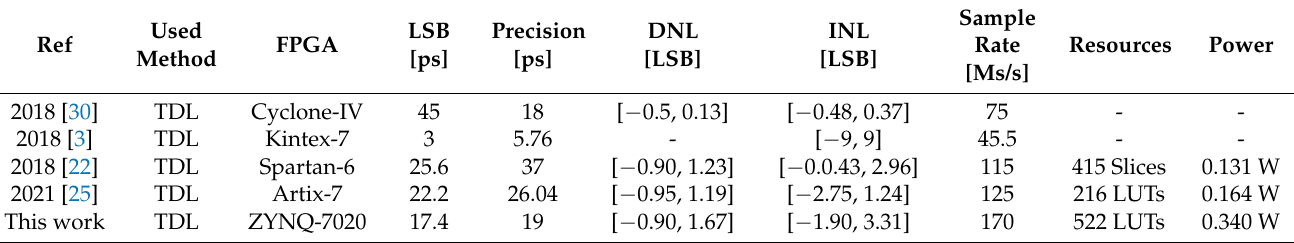
Table 6. Comparison with the FPGA-based